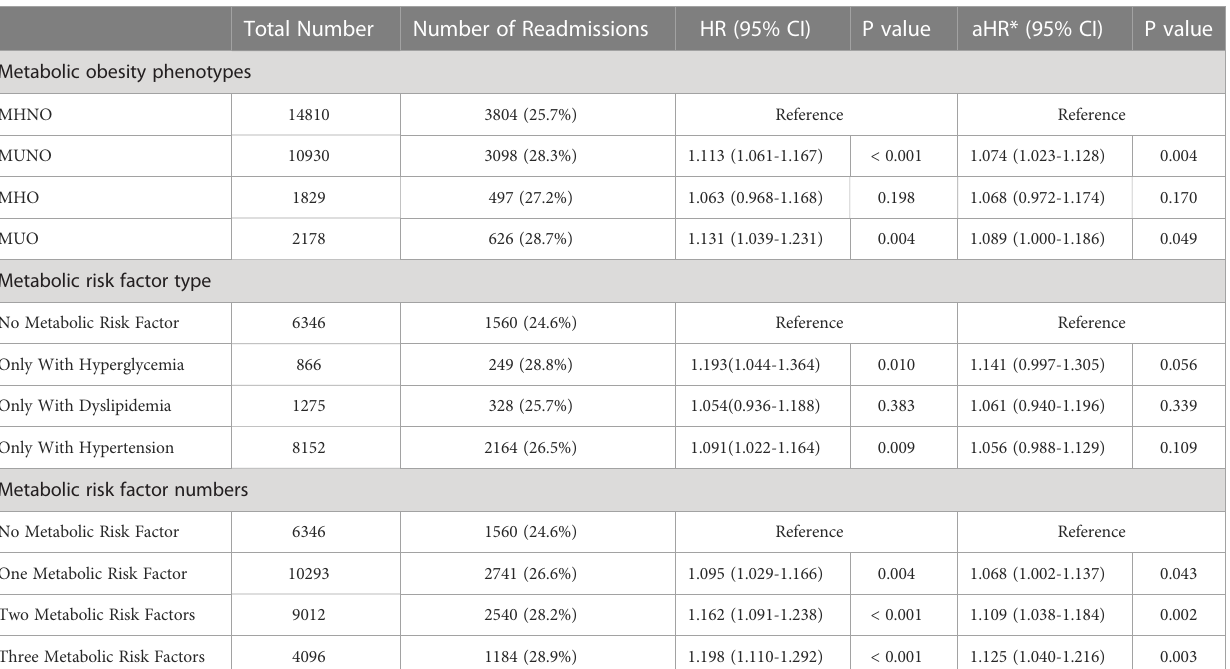
TABLE 2 Readmission risk of different metabolic status groups in 90-day